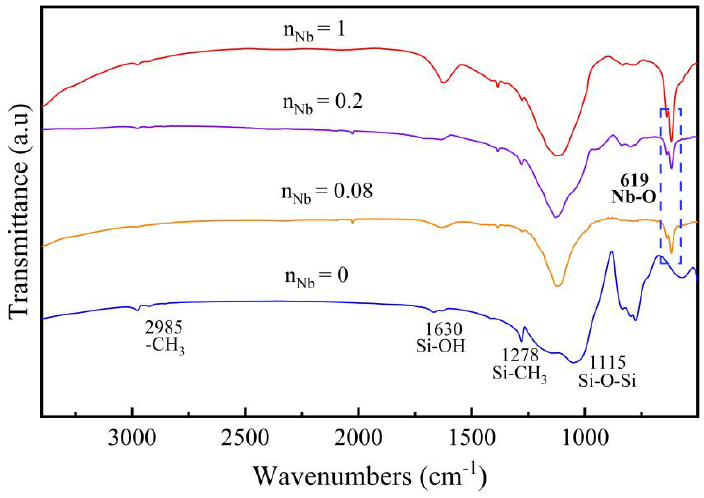
Figure 5. FTIR spectra of Nb/SiO 2 materials with various n Nb calcined at 400 °C.